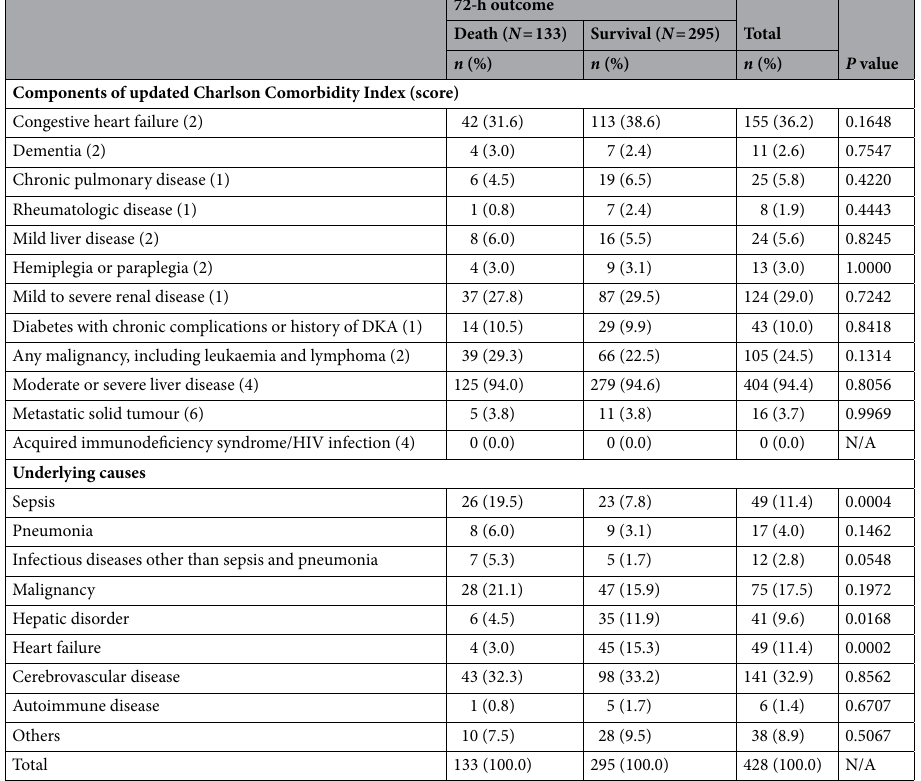
Table 2. Patient characteristics, demographics, components of the Charlson Comorbidity Index, and underlying causes. DKA, diabetic ketoacidosis; HIV, human immunodeficiency virus. P-values were calculated using Fisher’s exact